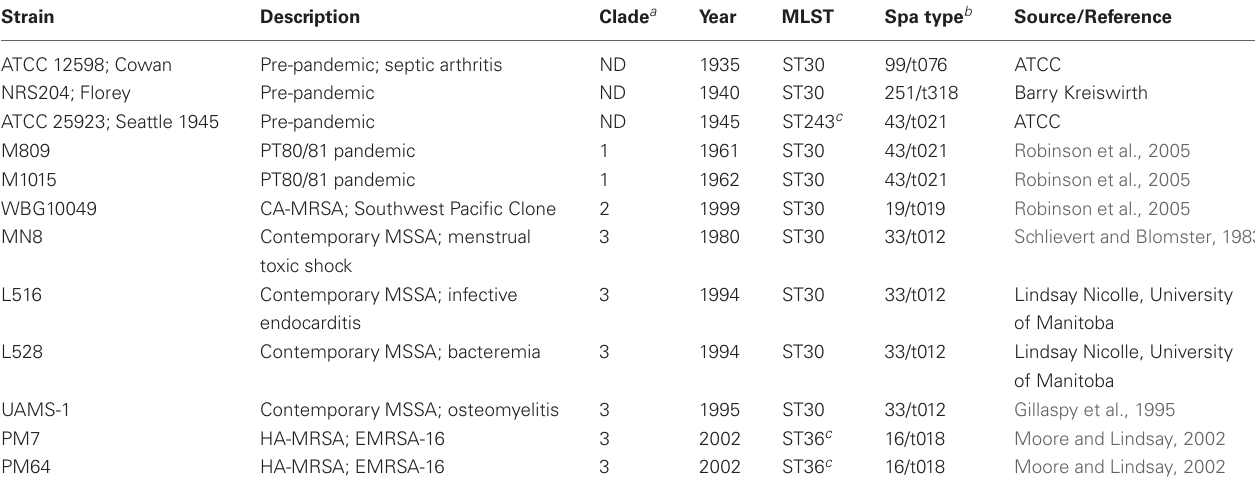
Table 1 | Strains used in this